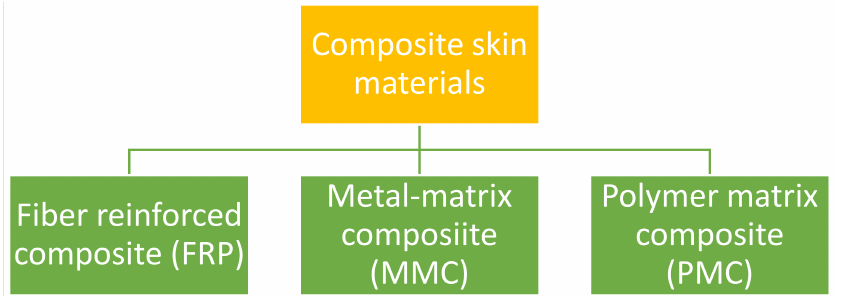
Figure 16. Classification of composite skin